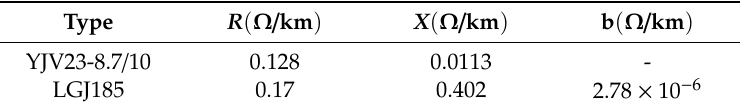
Table 2. The parameter of the transformer.